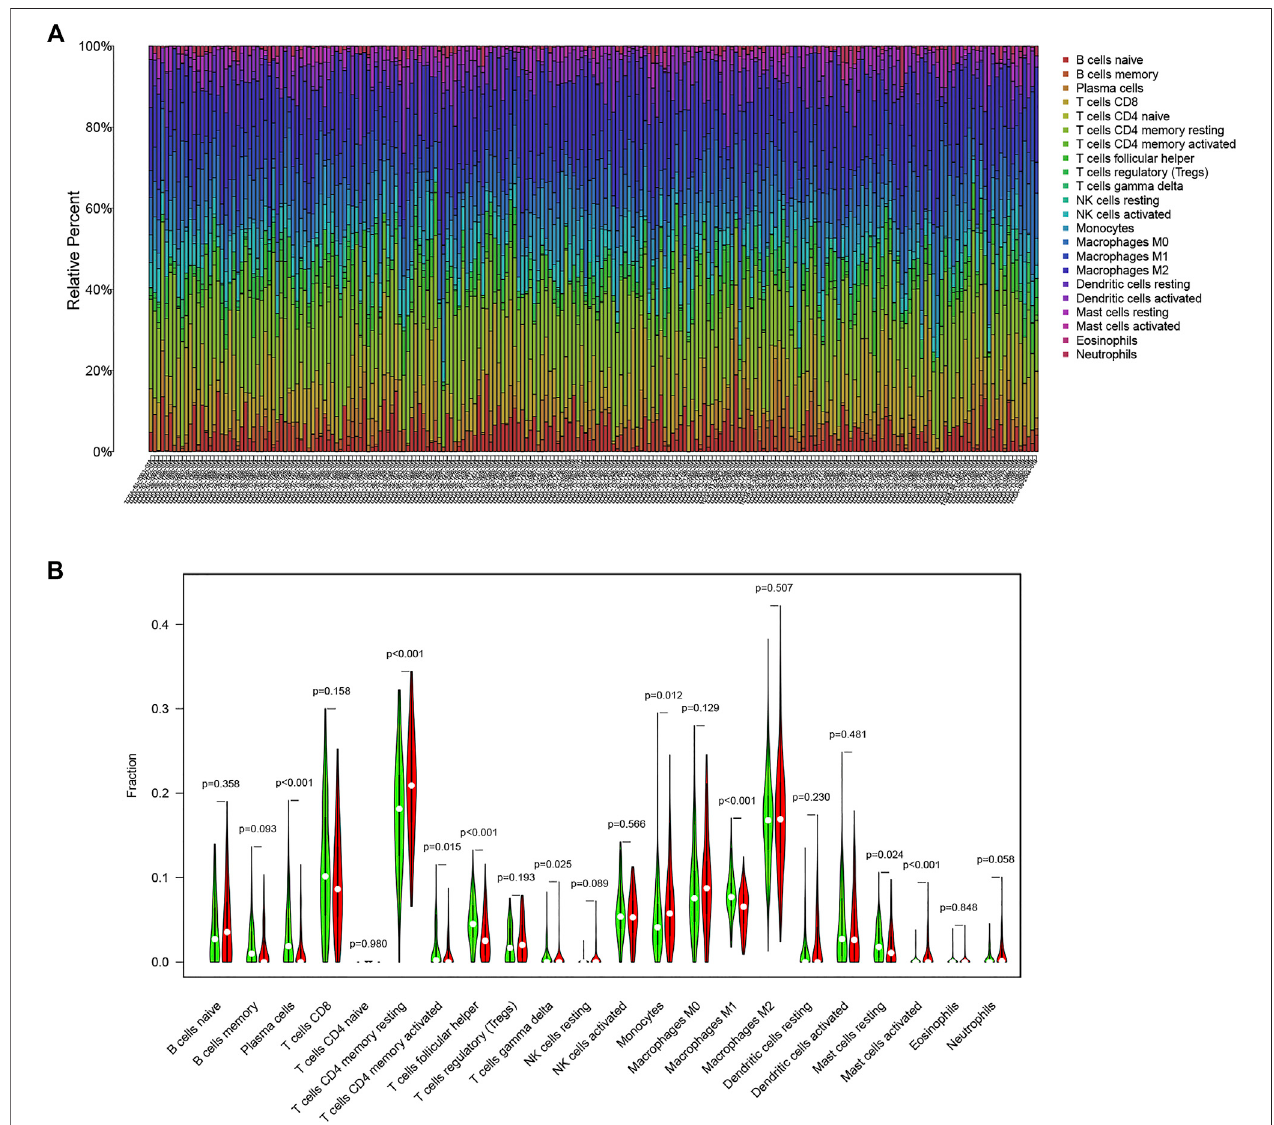
FIGURE 5 | Immune in fi ltration in OC. (A) Bar plot of the proportion of 22 immune cells in the TCGA-OC patients (B) Comparison of 22 immune cell in fi ltration between the two groups in the high-risk and low-risk groups (red means the high-risk group; green means the low-risk group).